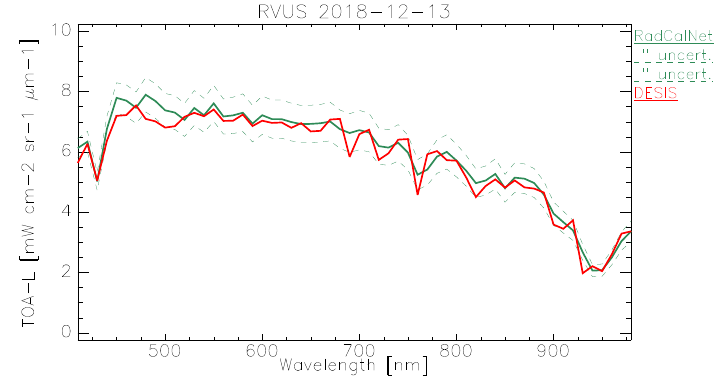
Figure 11. Comparison of RadCalNet TOA-L to DESIS mean TOA-L for RadCalNet location, RVUS, 13 December 2018, resampled to RadCalNet spectral resolution.